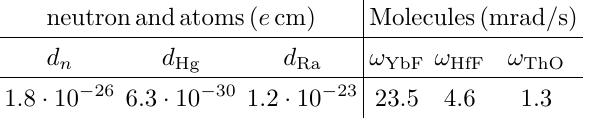
Table 3 . Current experimental limits (at 90 % C.L.) from measurements on the neutron [3], 199 Hg [1], 225 Ra [86], YbF [87], HfF [88], and ThO [89].